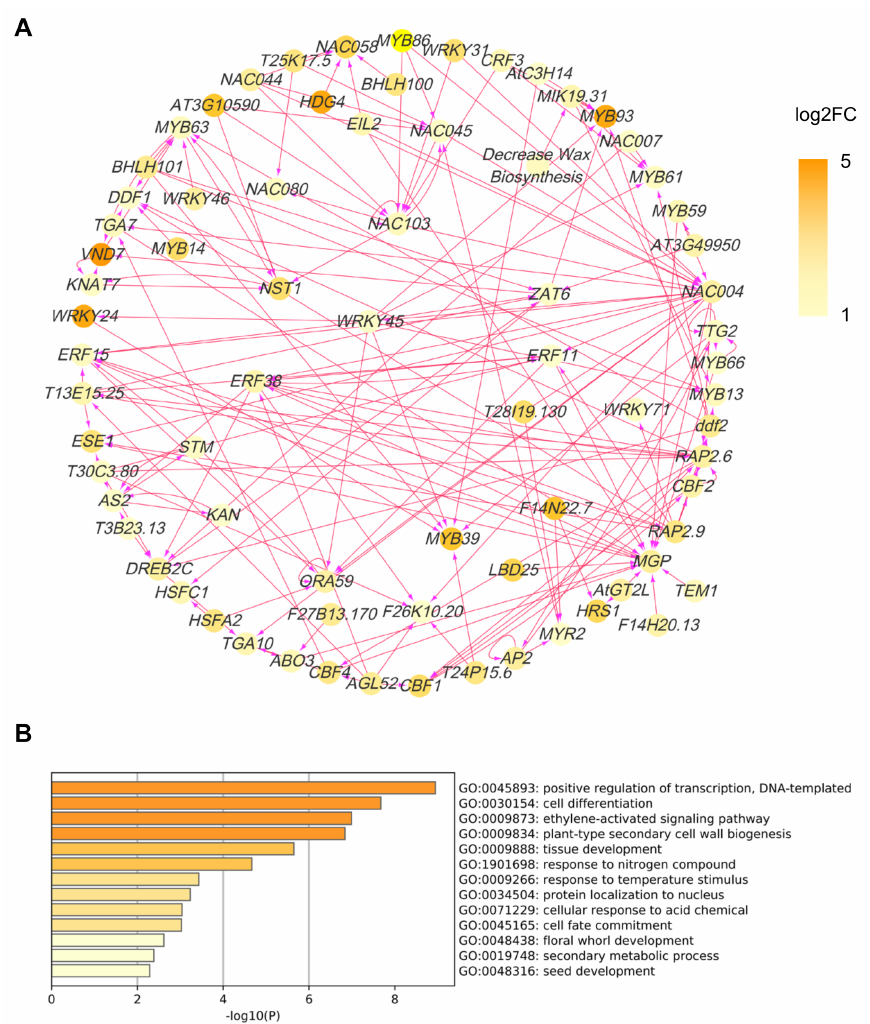
Figure 8. Analysis of the transcription factor (TF) network of the DEGs in the cotyledons of coe2 . ( A ) The TFs of DEGs of cotyledons of coe2 were selected to build the TF regulatory network. The color key indicates low to high gene expression levels (log2 FC). ( B ) GO analysis of the TFs shown in ( A